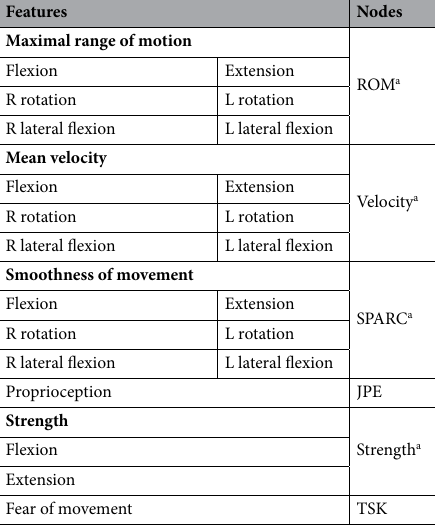
Table 1. Features and nodes included in the network analysis. JPE Joint position error, ROM Range of motion, SPARC Spectral arc length, TSK Tampa scale for kinesiophobia. a Average values obtained from the directions of movement reported in the first column.